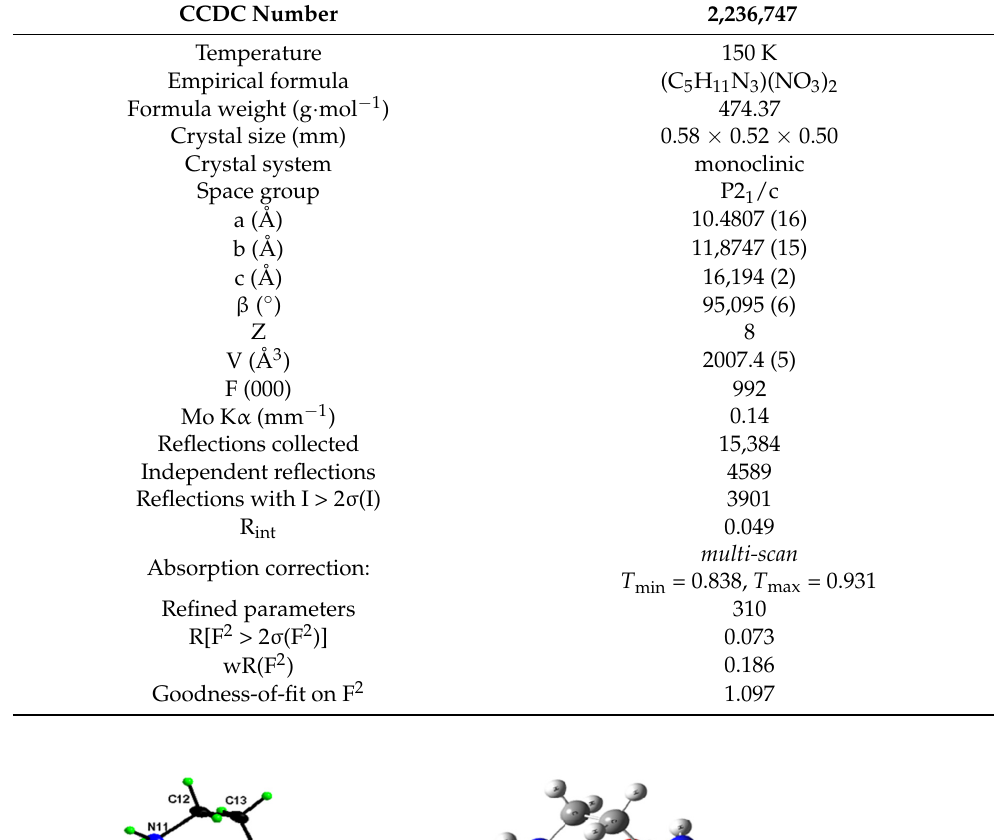
Table 1. Crystal data and experimental parameters used for the intensity data collection strategy and final results of the structure determination of HTN.